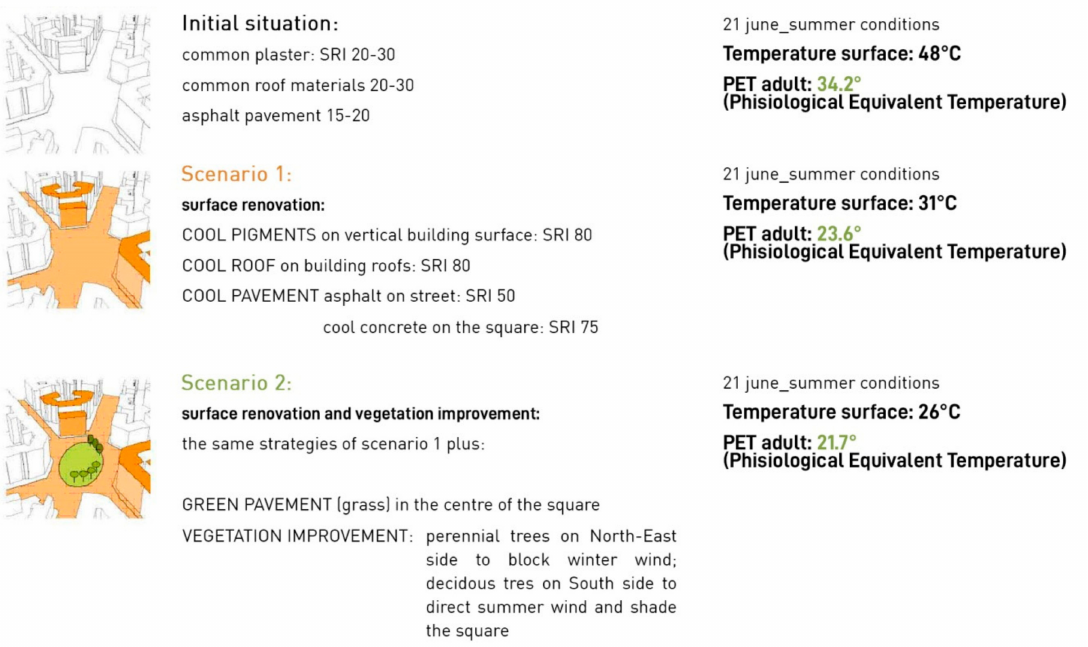
Figure 8. Summary of the comparison between the initial situation (S0) and the two di ff erent scenarios (S1 and S2) during summer (21 June).